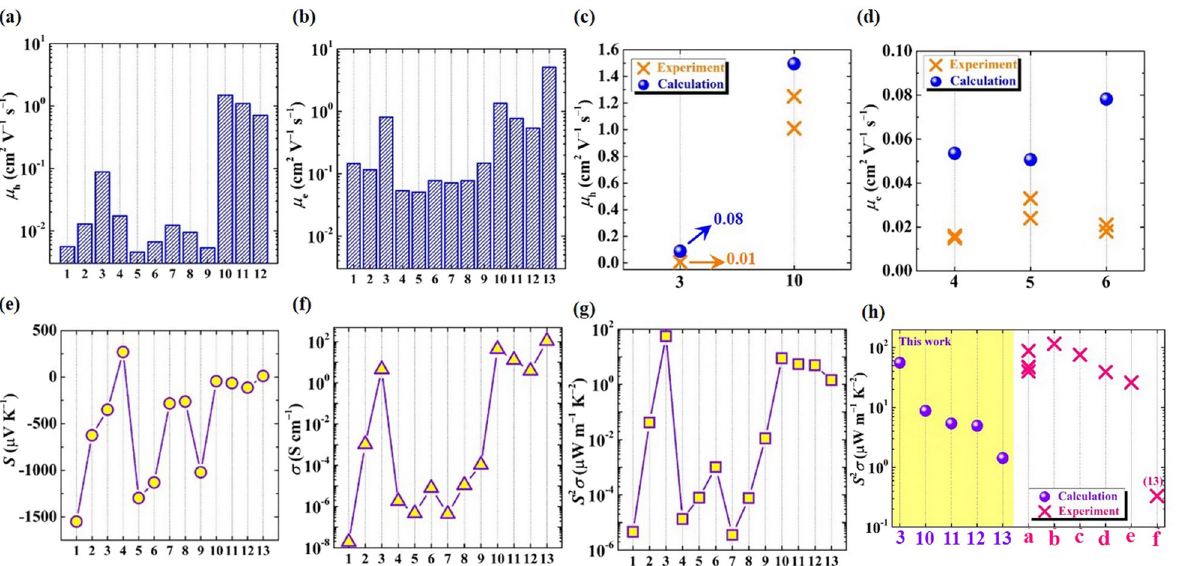
μ Fig. 2 Charge transport and TE response performance. The calculated a hole ( μ h ) and b electron ( e ) mobilities at room temperature. c The comparison between the calculated hole mobilities ( μ h , circle) and the measured ones (cross). d The comparison between the calculated electron mobilities ( μ e , circle) and the measured ones (cross). The calculated e Seebeck coef fi cient ( S ), f conductivity ( σ ), and g power factor ( S 2 σ ) at room temperature. h The calculated power factor ( S 2 σ ) for the fi ve best materials among our studied systems at room temperature (circle). The measured power factors (cross) for some current advanced donor – acceptor complexes are also displayed in the fi gure. The compound a – f stand for (BTBT) 2 X F 6 , Cu(DMDCNQI) 2 , (TTF)(TCNQ), (TTM-TTP)(I 3 ) 5/3 , (TMTSF) 2 PF 6 , and (DPTTA)(F 4 TCNQ), respectively, and their full names are shown in Supplementary Table 5. The corresponding references of the published experimental works in c , d , and h are summarized in Supplementary Table